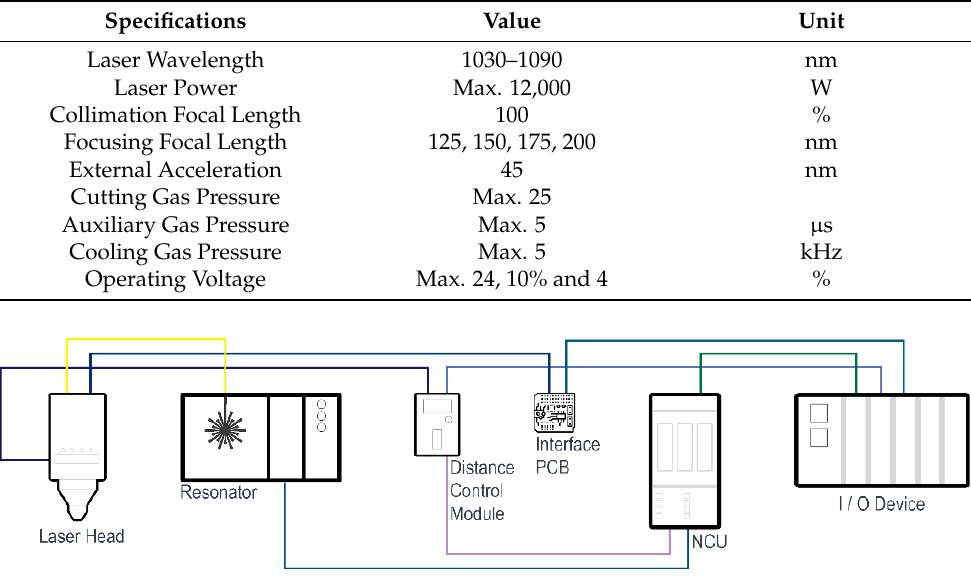
Table 3. Optical characteristics of laser resonator.